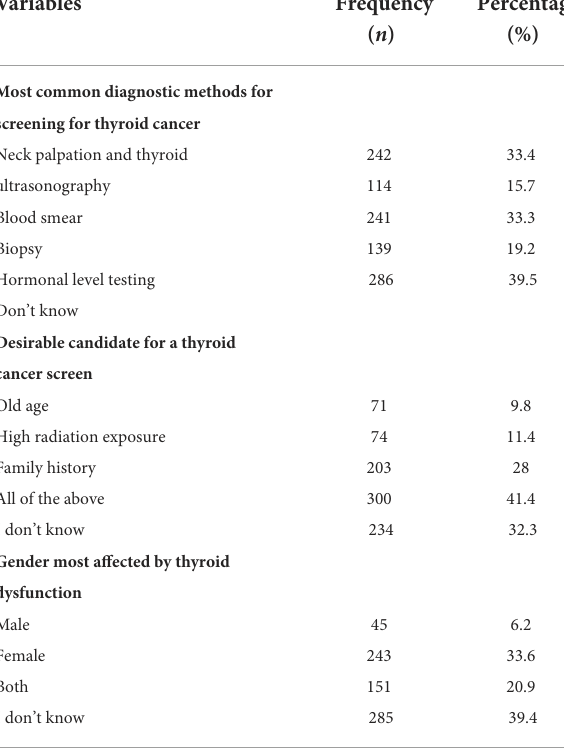
TABLE 2 Participant’s responses toward knowledge of thyroid cancer. TABLE 3 Frequency of correct answers regarding the knowledge of warning signs for